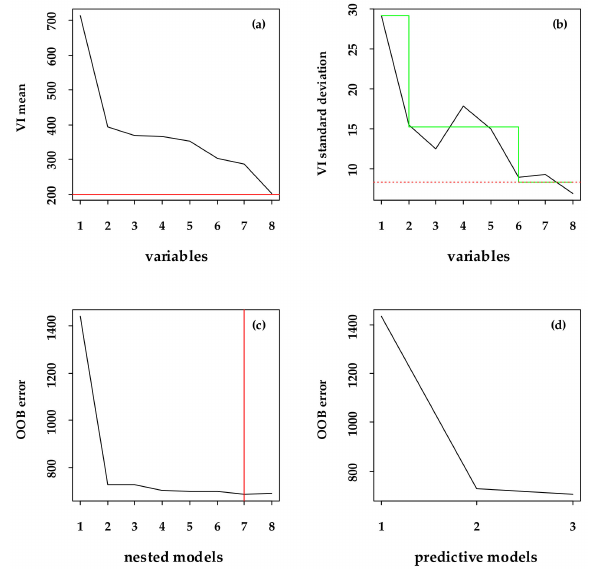
Figure 3. The variables selection of BBM. ( a , b ) Removes the negatively important variables based on the variable importance (VI) mean and standard deviation, respectively (( a ), the threshold position is represented by a solid red line that runs horizontally, and ( b ), the green segmented line represents the predicted value given by the CART model, and the red line with dashes running horizontally represents the minimum predicted value). ( c ) Gradually builds a random forest from only the most important variables to all variables selected in the first step, and selects the corresponding variables according to the average OOB error (the vertical solid red line indicates the minimum error position). ( d ) Gives the number of variables meeting the requirements.